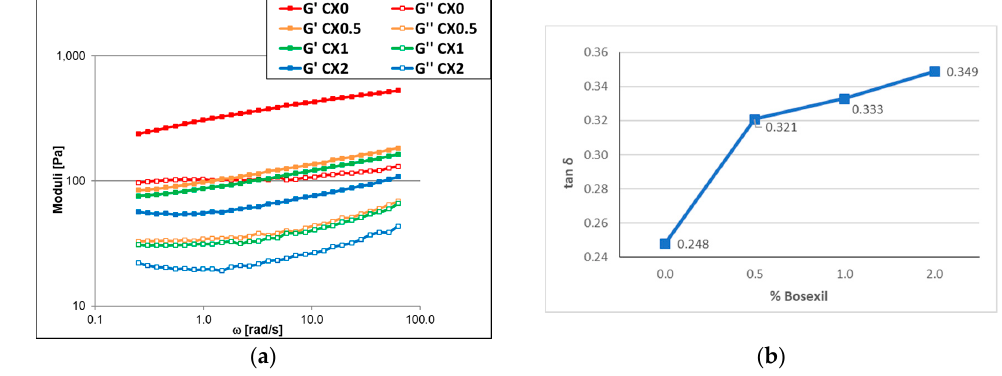
Figure 2. ( a ) Elastic (G ′ ) and viscous (G ″ ) moduli in function of frequency of CX0, CX0.5, CX1, CX2 samples, at 1% strain; ( b ) tan δ values of samples (at 10 rad/sec) prepared with different concentration of Bosexil ® (0%, 0.5%, 1%, 2%).